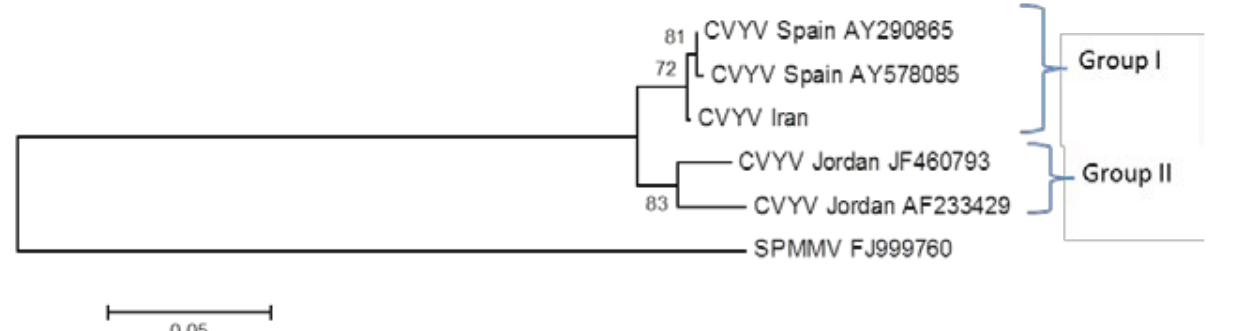
Figure 3. Phylogenetic tree based on Cucumber vein yellowing virus (CVYV) sequences available at GenBank and the isolate from Iran. The tree was inferred with 1000 bootstrap replicates of the maximum likelihood procedure applying MEGA 5 default settings. Bootstrap values above 70% are shown at the nodes. Sweet potato mild mottle virus (SPMMV) was used as the out